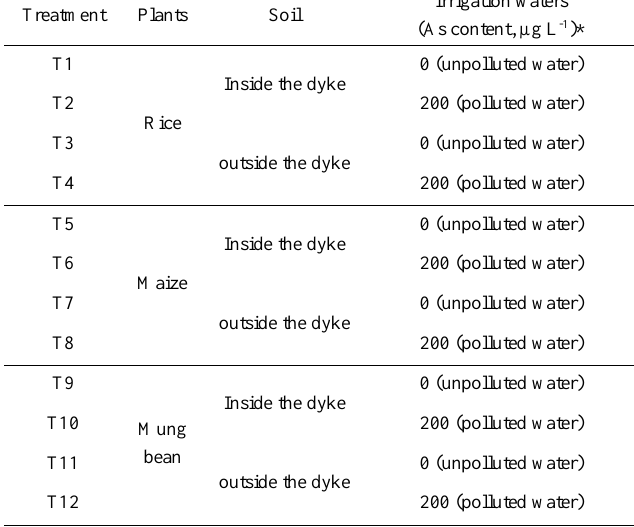
Fig.2. The experimental site, Phuoc Hung commune, An Phu district